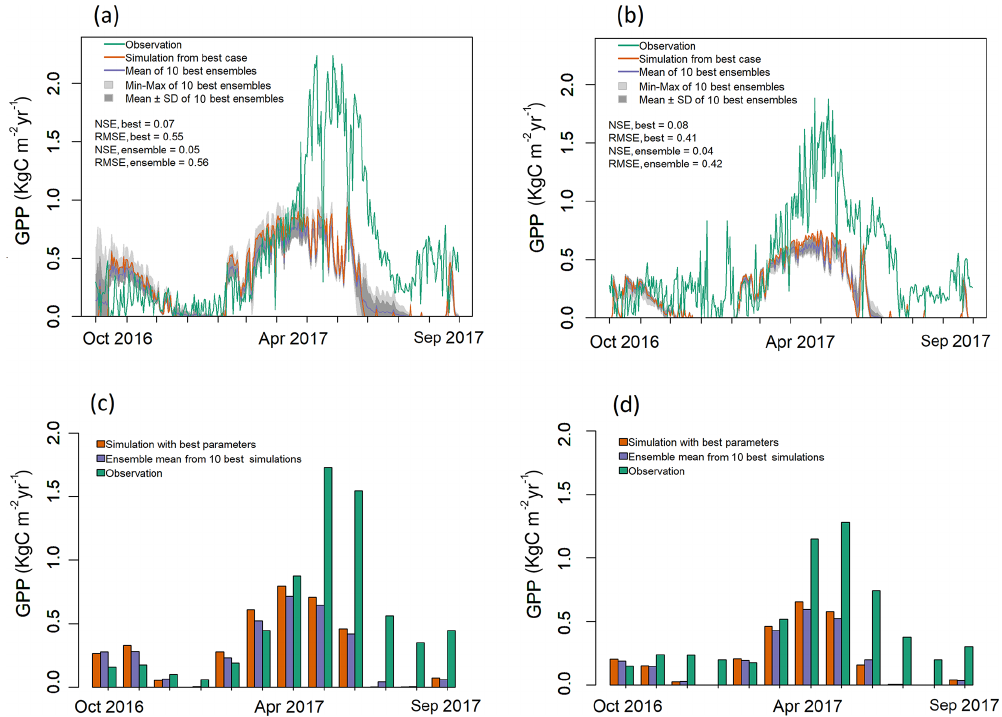
Figure 4. Observed and simulated GPP for validation period (water year 2017) for both EC towers. (a–b) Simulated daily GPP (kgCm − 2 yr − 1 ) from best case, 1 standard deviation of ensembles, and range of ensemble simulations compared with observations for (a) LS and (b) WBS sites. (c–d) Simulated mean monthly GPP (kgCm − 2 yr − 1 ) from best case and ensemble means compared against observation data for (c) LS and (d) WBS